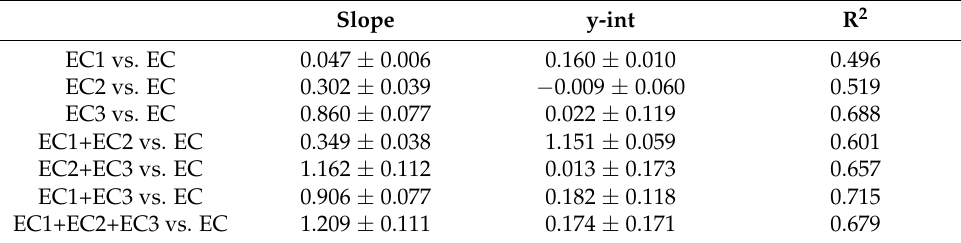
Figure 5. The relationship between EC fractions and EC concentration: ( a ) EC1 vs. EC, EC2 vs. EC and EC3 vs. EC; ( b ) EC1 + EC2 vs. EC; ( c ) EC1 + EC3 vs. EC; ( d ) EC2 + EC3 vs. EC; ( e ) EC1 + EC2 + EC3 vs. EC. Table 2. Summary of linear regression on the EC fractions and their combination versus EC